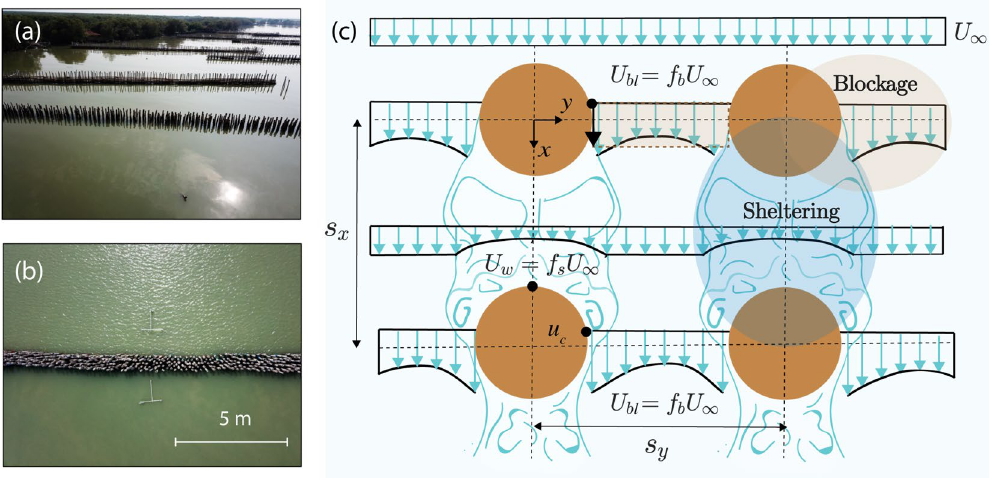
Figure 1. ( a ) Pictures of bamboo structures built by the Indonesian Ministry of Marine Affairs and Fisheries in Demak, Indonesia. The structures are formed by arrays of bamboo poles with a diameter of d distributed over a width of approximately 1.5 m in the streamwise direction. Their volumetric porosity ranges between n 0.5 and 0.9. ( b ) Top view of one of the structures. Both drone pictures are courtesy of S.A.J. Tas. ( c ) ≈ Sketch representing the effects of blockage and sheltering on the local flow velocity (blue arrows) at the scale of the bamboo poles of a structure (solid brown circles), inspired by Etminan et al. 11 and Zdravkovich 12 . Incoming flow velocities U accelerate to U bl between the cylinders, an effect known as blockage. Behind the first row of ∞ cylinders, velocities reduce to U w due to sheltering effects. The relative magnitude of these effects depends on the streamwise and lateral or spanwise spacing of the cylinders ( s x and s y ,